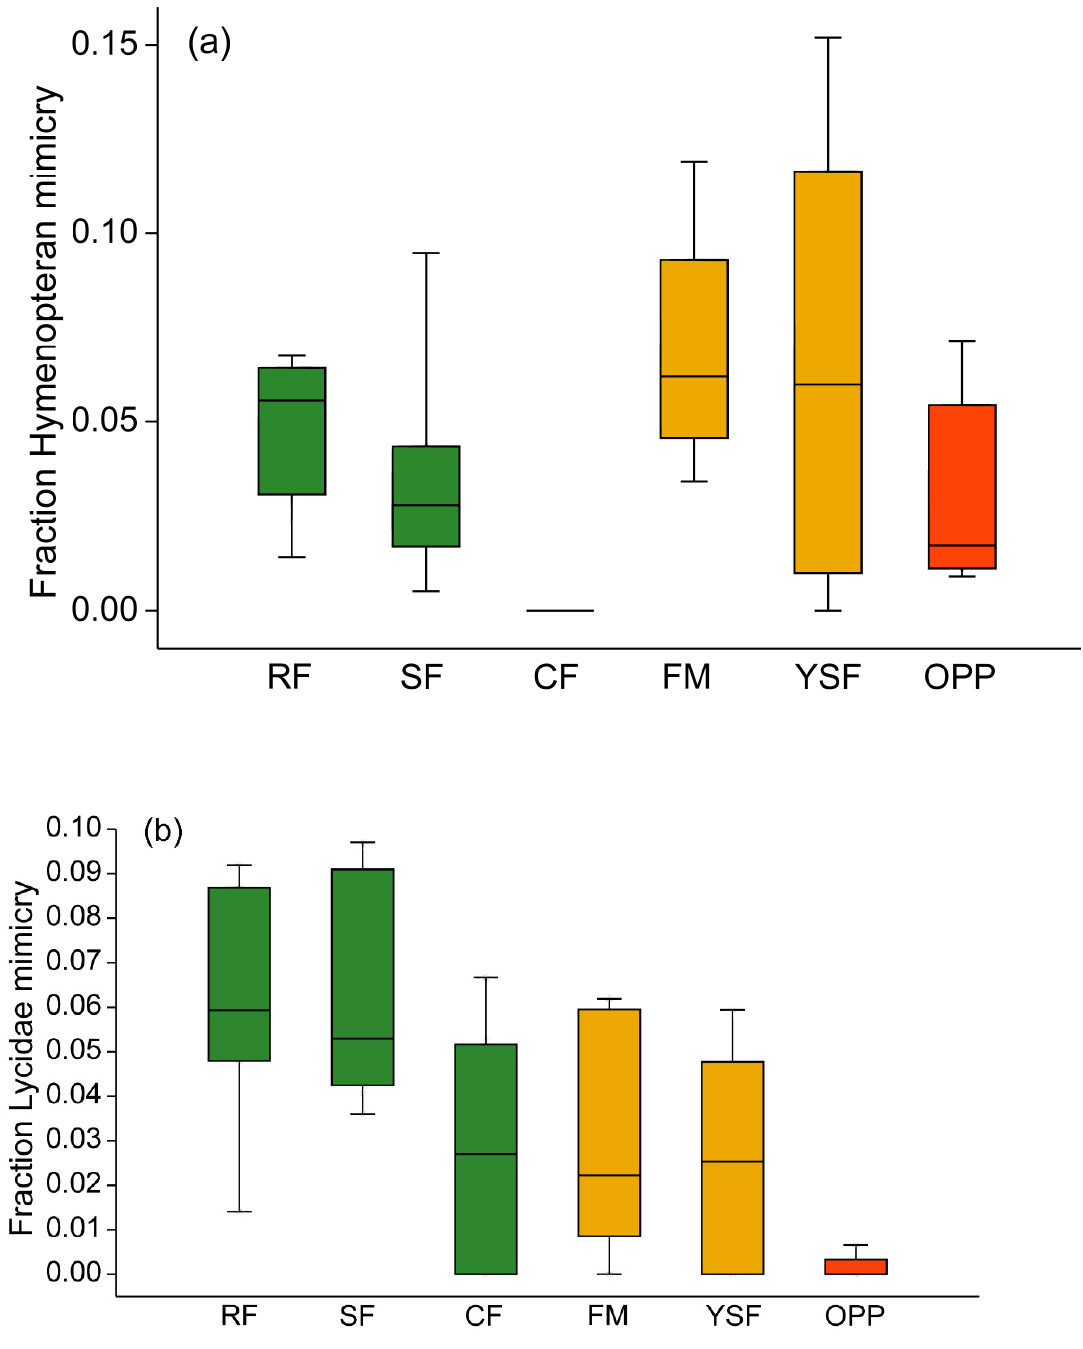
Figure 5. Box plots of community weighted means of hymenopteran mimicry ( a ) and Lycidae beetle mimicry ( b ) among Arctiinae assemblages. Green: old-growth forest; orange: disturbed forest sites; red: oil palm plantations. RF—ridge forest; SF—slope forest; CF—creek forest; FM—forest margin; YSF—young secondary forest; OPP—oil palm plantations. Box: upper and lower quartile; horizontal line in box: median; whiskers: highest and lowest value.